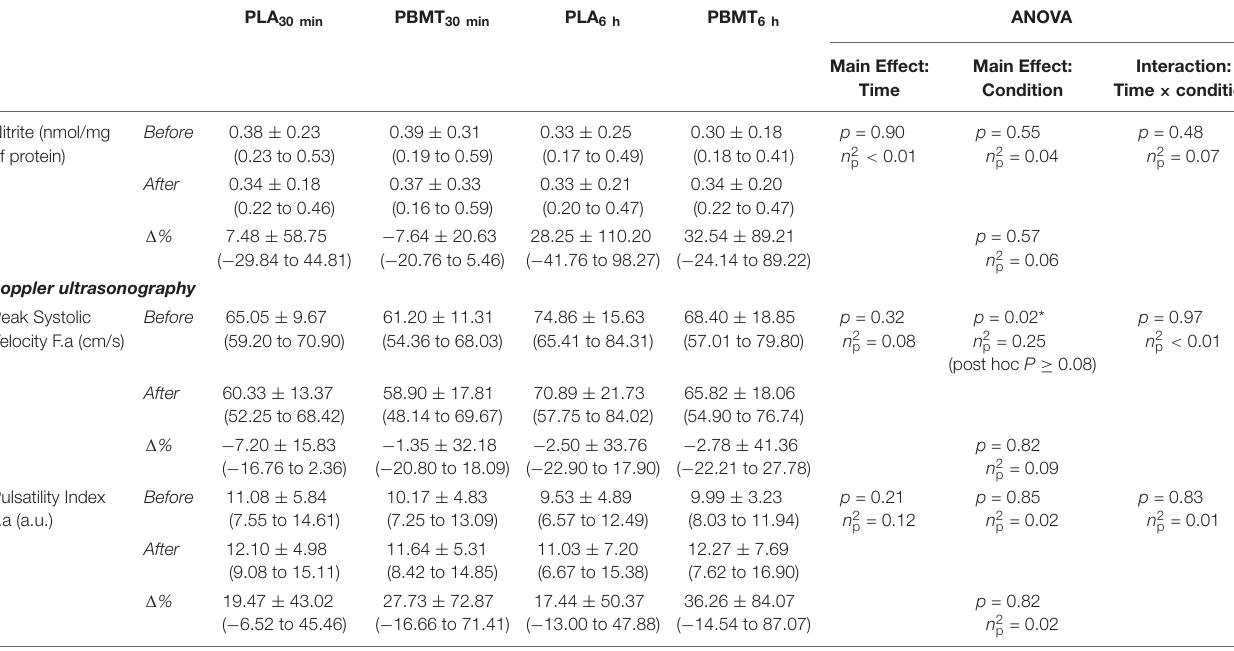
TABLE 1 | Blood nitrite concentration and Doppler Ultrasound exam outcomes of the femoral artery before and after treatments.